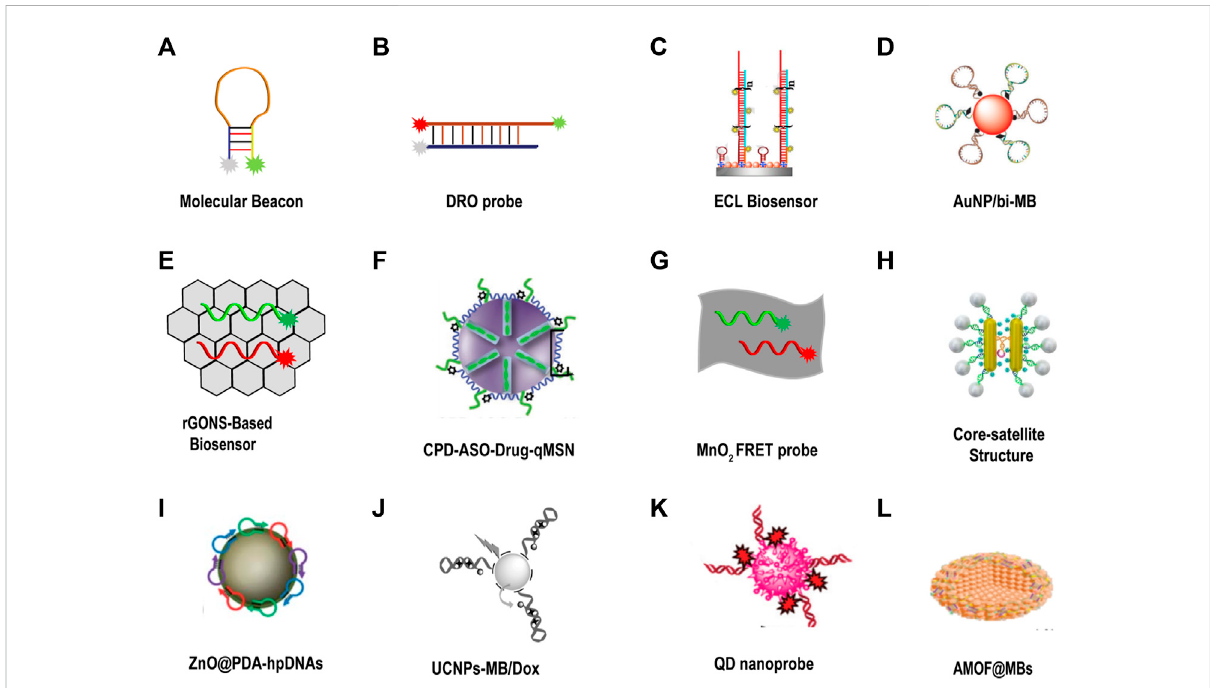
FIGURE 10 DNA fl uorescent probe for tumor-related imaging in living cells. (A) Molecular beacon (Tyagi and Kramer, 1996). (B) Dual-colored ratiometric fl uorescent oligonucleotide probe (DRO) (Ning et al., 2017). (C) Electrochemiluminescence (ECL) biosensor (Zhao et al., 2020). Copyright 2020 Elsevier. (D) AuNP was assembled with a bi-molecular beacon (bi-MB), and termed AuNP/bi-MB (Qiao et al., 2011). Copyright 2011 Wiley. (E) rGONS-based biosensor (Fan et al., 2019). (F) CPD-ASO-Drug-qMSN (Yuan et al., 2017). Copyright 2017 Wiley. (G) MnO 2 nanosheet mediated “ DD – A ″ FRETbinaryprobes (Ouetal.,2017). (H) Core-satellitestructure(Maetal.,2017).Copyright2018AmericanChemical Society. (I) ZnO@PDA- hpDNAs (He et al., 2017). Copyright 2017 The Royal Society of Chemistry. (J) UCNPs-MB/Dox (Ding et al., 2016). Copyright 2016 Wiley. (K) QD nanoprobe (Lin et al., 2021). Copyright 2020 The Royal Society of Chemistry. (L) AMOF@MB (Liu et al., 2019). Copyright 2019 The Royal Society of